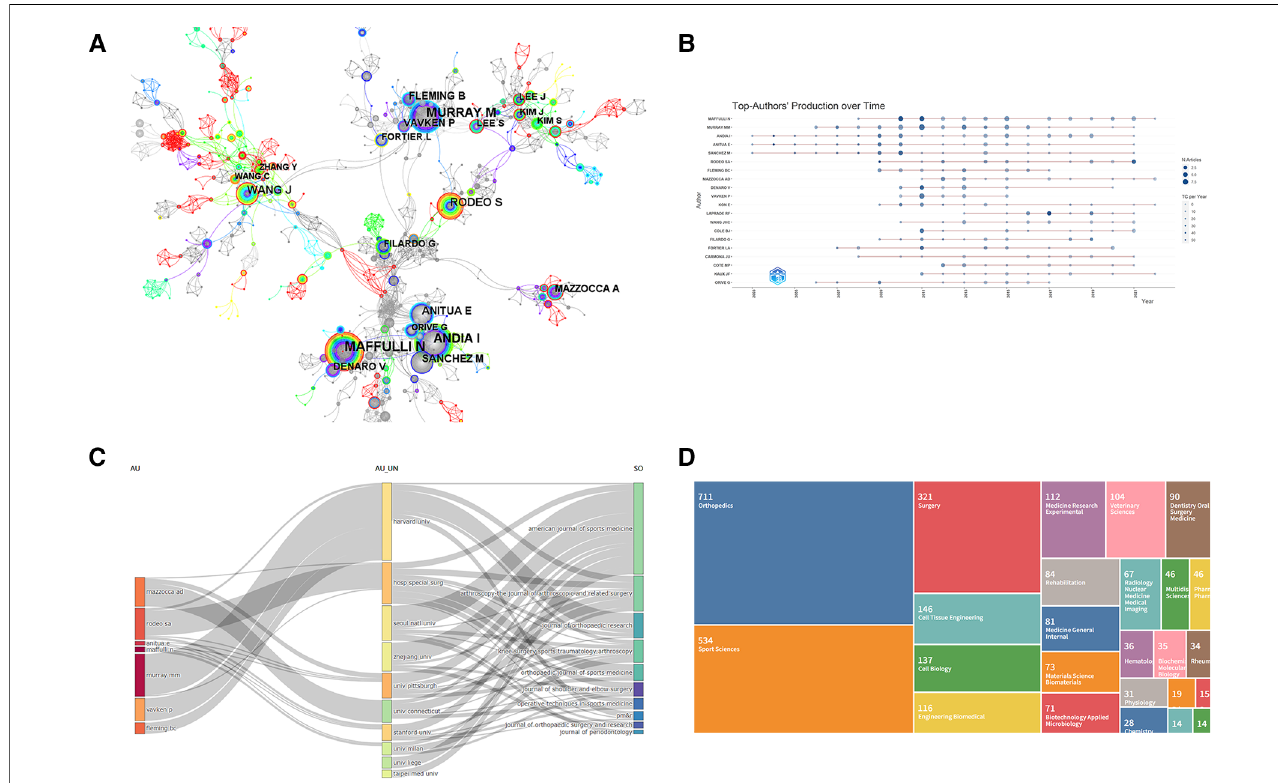
FIGURE 3 ( A ) author co-occurrence network diagram of using platelet-rich plasma to treat ligament and tendon injuries. Note: The circles in the chart indicate the volume of posts. The larger the circle, the more the author posts, the thickness of the purple outer circle represents the author's centrality, and the connecting line represents the existence of cooperation or co-occurrence. ( B ) Plot of high yield authors over time for using platelet-rich plasma to treat ligament and tendon injuries. Note: The top twenty most proli fi c researchers in the fi eld and their publications. The larger the node, the more literature is published. The darker the color, the more citations. The color represents the number of publications, and the color represents the number of citations per year. ( C ) The three- fi eld plot shows the knowledge fl ow of platelet-rich plasma for the treatment of tendon and ligament injuries. ( D ) Distribution of hot research disciplines in the literature on using platelet-rich plasma to treat ligament and tendon